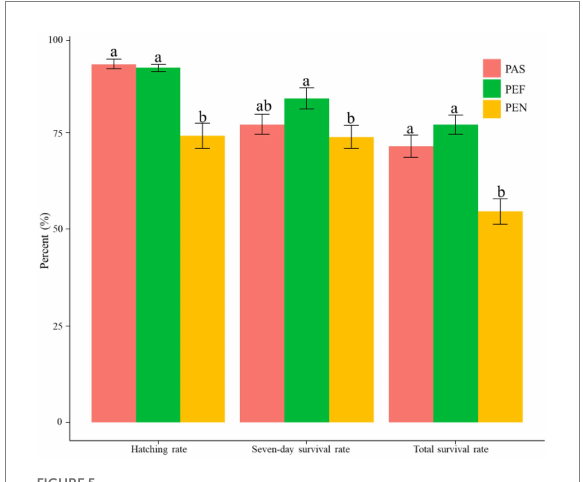
FIGURE 5 The comparison of hatching rate and survival rate among substrate groups. PAS, palm sheet; PEF, polyethylene filament; PEN, polyethylene net.